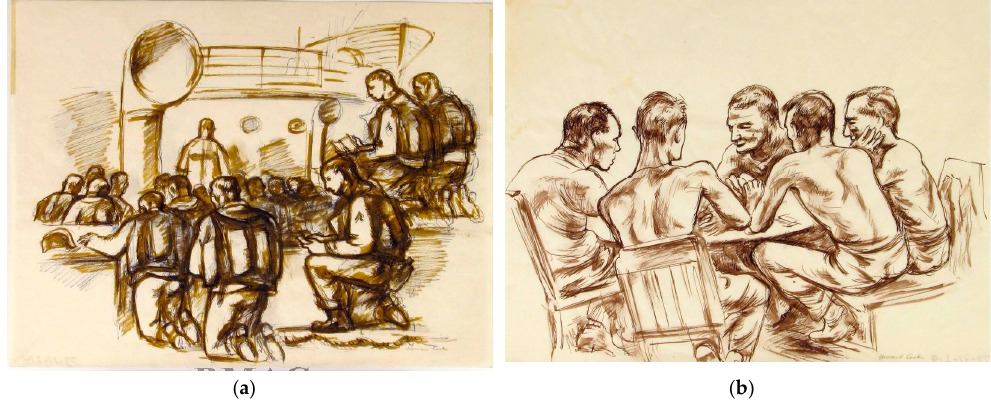
Figure 4. Most of Cook’s drawings focus on noncombat activities: ( a ) Howard Cook, Easter Service ( WWII ), 1943, ink on paper. Permanent Collection of the Roswell Museum and Art Center, Gift of the Artist, 1973.031.0214. Used with permission. ( b ) Howard Cook, Card Game , 1943, ink on paper. Permanent Collection of the Roswell Museum and Art Center, Gift of the Artist, 1973.031.0219. Used with